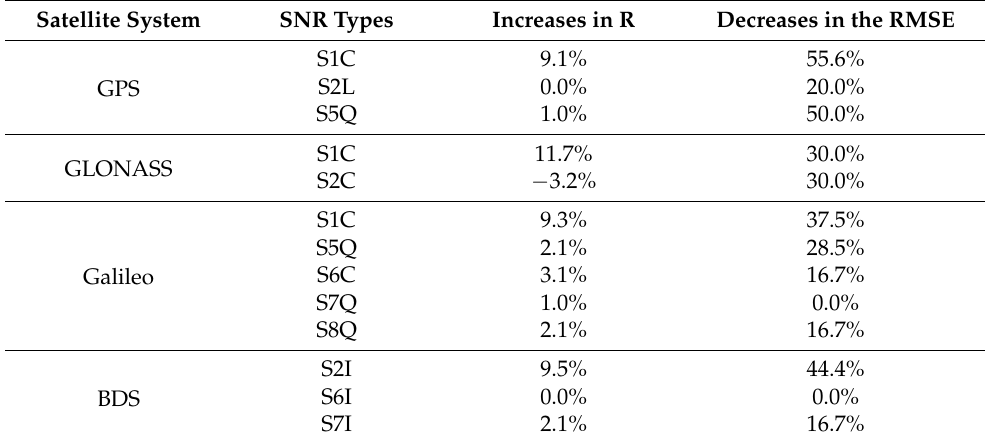
Figure 15. Mean fusion accuracy analysis of multi-frequency retrieval results in the four GNSS systems: ( a ) GPS multi-frequency fusion; ( b ) GLONASS multi-frequency fusion; ( c ) Galileo multi-frequency fusion; ( d ) BDS multi-frequency fusion. Table 4. Comparison of different frequency signal in the multi-GNSS system retrieval results; multi-frequency mean fusion accuracy increases in R and decreases in the RMSE.